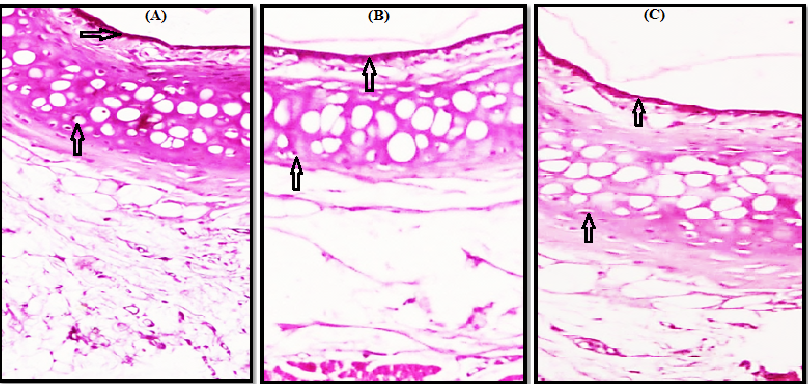
epithelium and subepithelial glands as shown by arrows, ( A ) Control, ( B ) F1, and ( C ) F17.